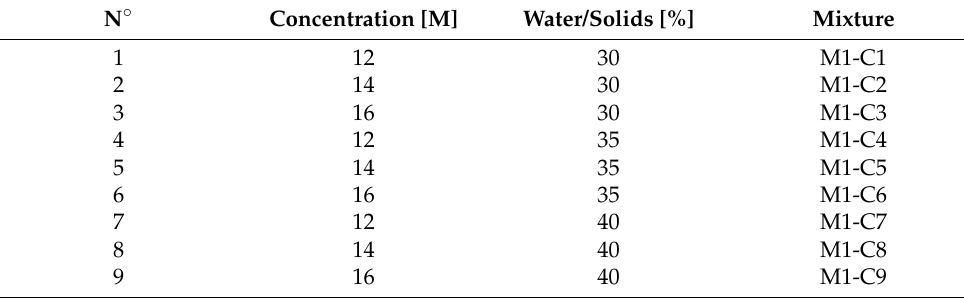
Table 4. Proportions of the mixtures to be